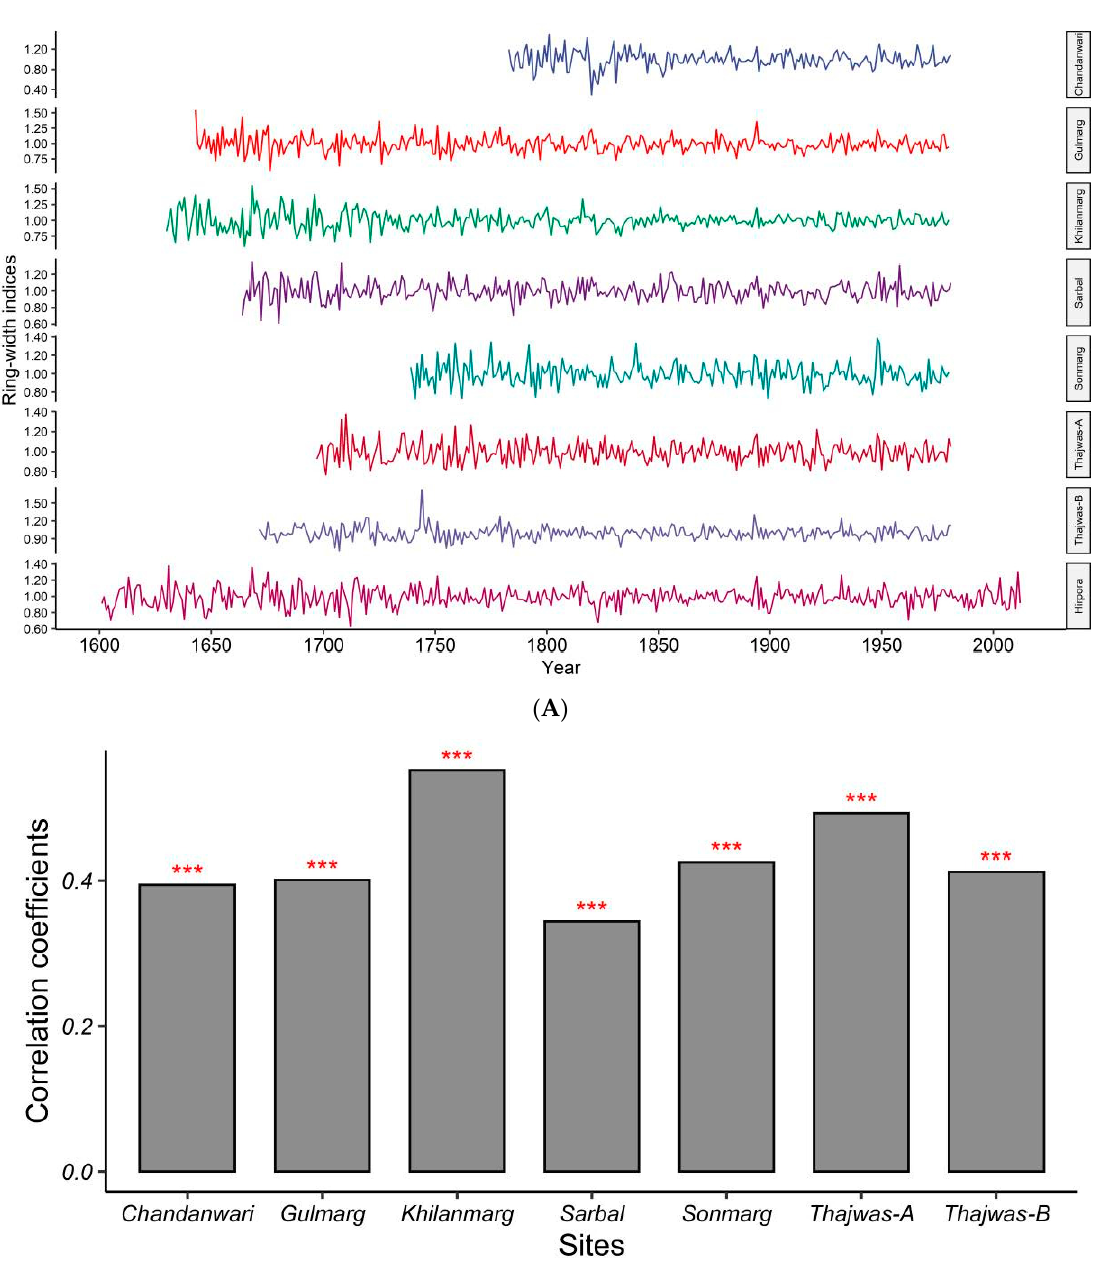
Figure 9. ( A ). Residual site chronologies of Hirpora and various sites sampled by M K Hughes [17,18]. ( B ). Correlation plot showing correlation coefficients between Hirpora and other residual site chronologies (The asterisk marks *** above bars show statistical significance at p < 0.01).